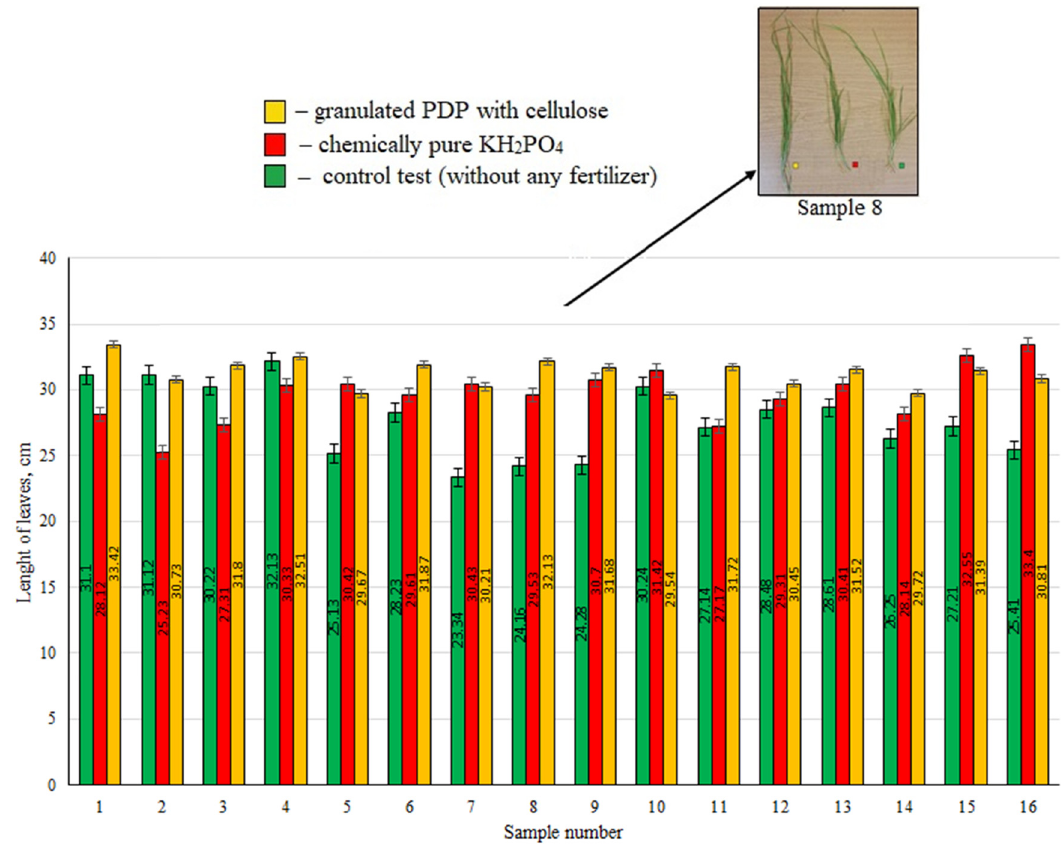
Figure 5: Length of leaves dependency on the type of fertilizers.